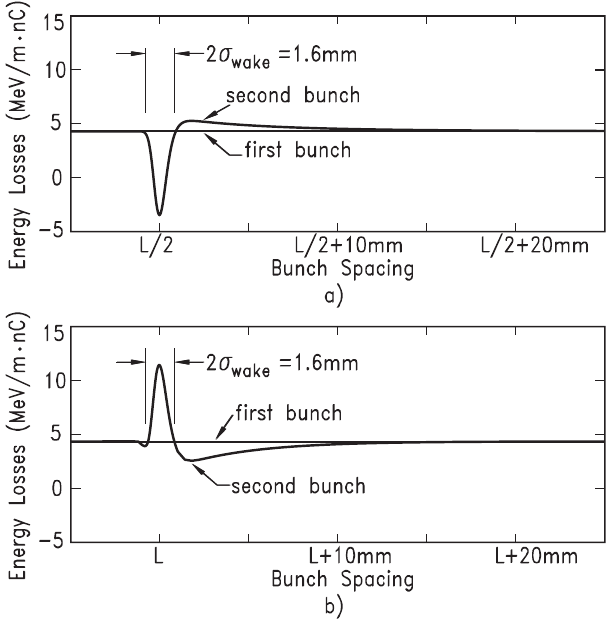
FIG. 1. The behavior of W (cid:7) 1 (cid:8) =Q